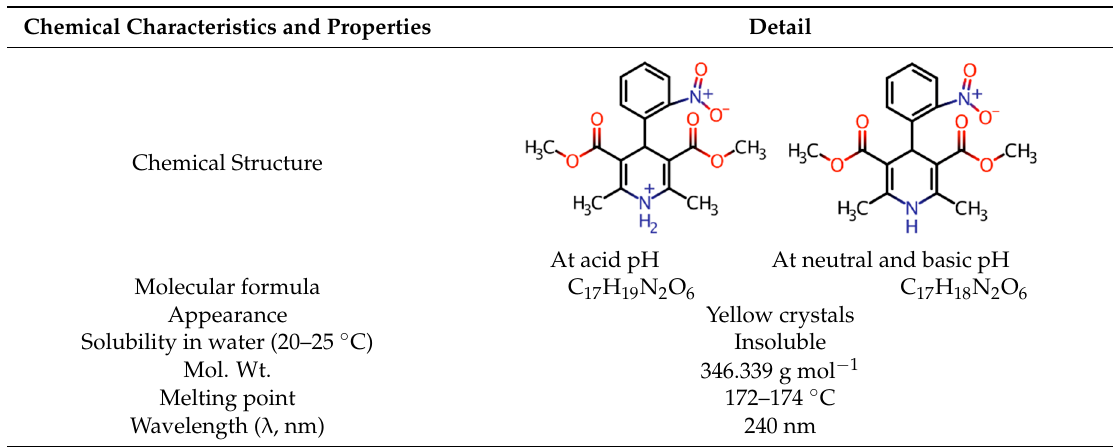
Table 1. Chemical structure and properties of Nifedipine (NFD) [4].